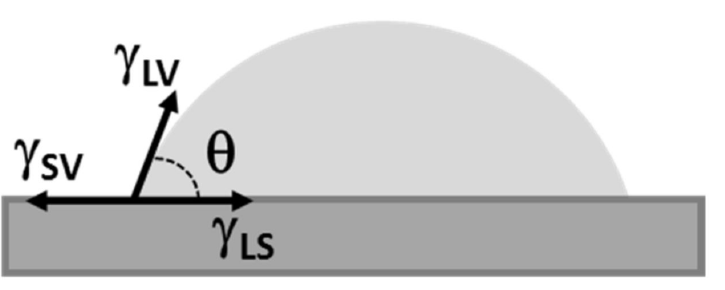
Figure 3. Representation of the process of wetting in the absence of interaction between the phases.